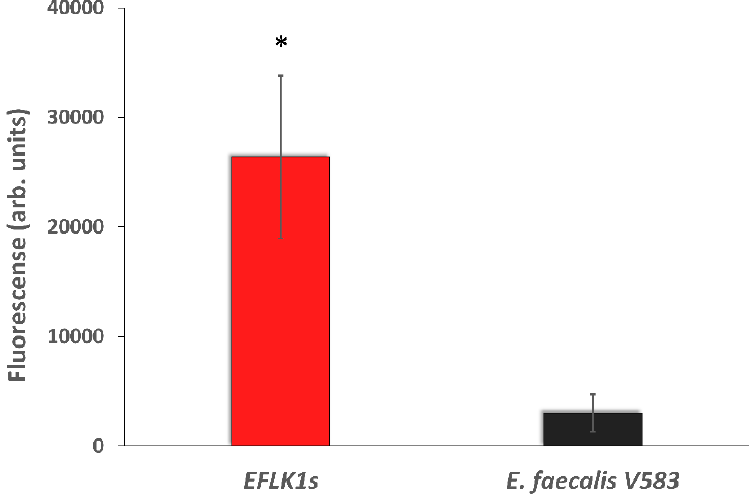
Figure 8. Fluorescence activated cell sorting (FACS) analysis: higher fluorescence levels are obtained followed phage treatment. Red = EFLK1 survivors, black = untreated control of E. faecalis V583. Statistically significant ( p < 0.01) compared to the untreated control. The results are mean ± SD based on six independent biological replicates.